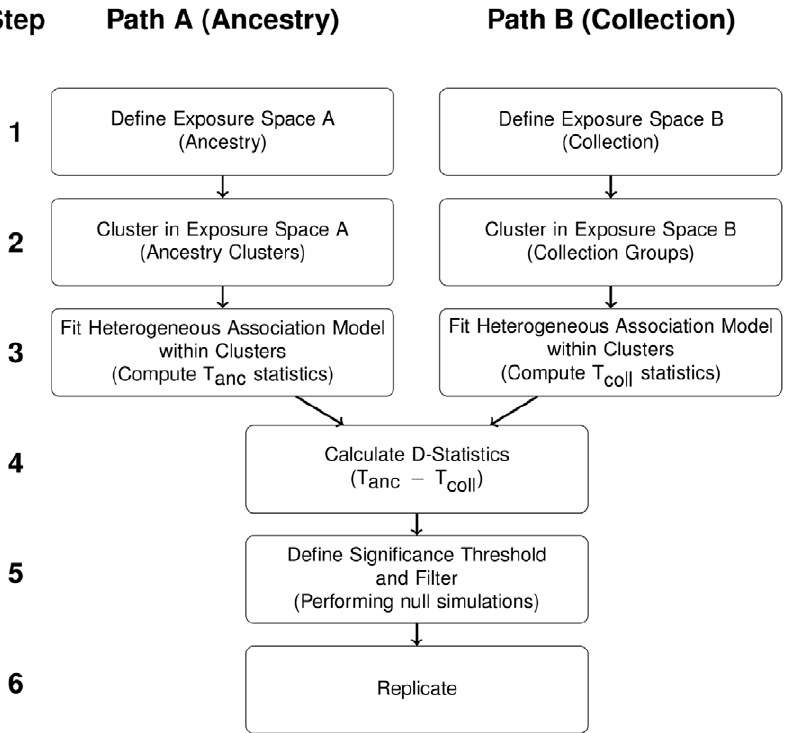
Figure 1. Summary of the Methodology. Flow diagram showing methodological steps for testing for interactions when there are two comparable sources of heterogeneity. There are two paths (A and B) in the work flow, one for each source. In our case path A corresponds to ancestry and path B corresponds to collection. If there is only a single collection, path A can be followed with steps 1A, 2A, 3A, 5, and 6 (i.e. without computation of D-Statistics). T anc is the heterogeneity test statistic computed with the ancestry clustering and T coll is the heterogeneity test statistic computed with the collection clustering as defined in the methods.